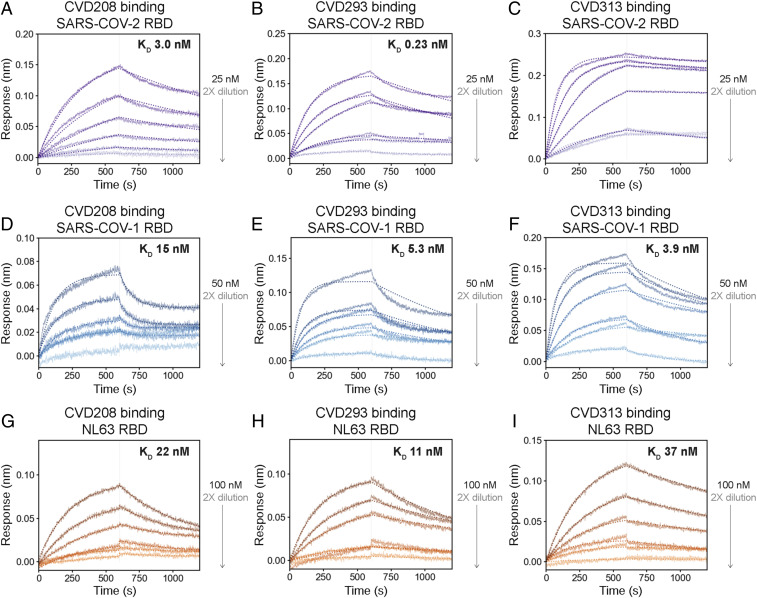
WT and engineered ACE2(740)-Fc bind the SARS-CoV-1 RBD and the HCoV-NL63 RBD. Representative BLI measurements for (A, D, and G) WT ACE2(740)-Fc, (B, E, and H) K31F/H34I/E35Q ACE2(740)-Fc, and (C, F, and I) K31F/N33D/H34S/E35Q/H345L ACE2(740)-Fc interactions with the SARS-CoV-2 RBD (A–C), the SARS-CoV-1 RBD (D–F), and the HCoV-NL63 RBD (G–I) at concentrations of 0.375 to 100 nM RBD, with the highest RBD concentration tested and KD values as indicated. Dotted lines show calculated fits. The extremely slow off rate observed in C precluded KD determination.